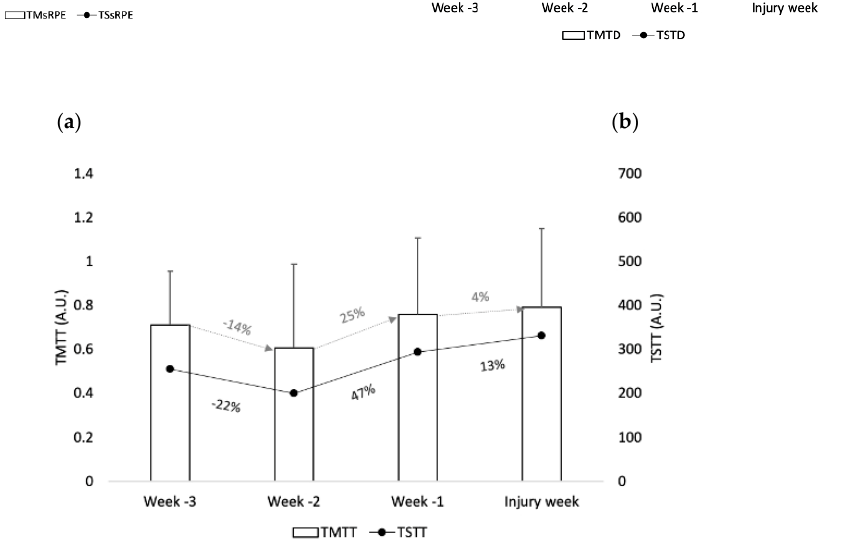
Table 1. Between-weeks variations of workload indices based on total distance before injury.